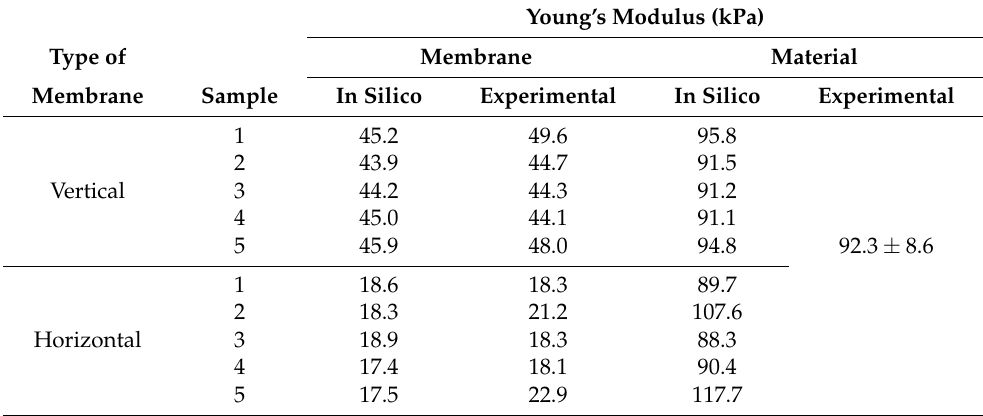
Table 1. Table summarizing the results of the calculation of the Young’s modulus of the membranes and of the material, both experimentally and in silico. In more detail, the table summarizes the values of Young’s modulus measured experimentally on five vertical (V1 to V5) and five horizontal (H1 to H5) membranes. The dimensions of the membranes and the values of elongation and force used To determine the experimental Young’s modulus of the membrane were employed to determine the Young’s modulus of the membranes in silico. These data were used to calculate by simulation the Young’s modulus of the material in order to validate the one measured experimentally (92.3 ± 8.6). Values of the maximum elongation and force, as well as the dimensions of the membranes (length, width, and thickness) can be found in Table S1—Supplementary Information. Young’s Modulus (kPa) Type of Membrane Material Membrane Sample In Silico Experimental In Silico